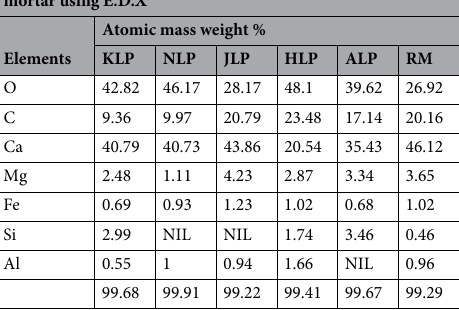
Table 13. Elemental analysis (E.D.X.) of modified organic lime paste. K.L.P.: kadukkai lime paste, N.L.P.: neelamari lime paste, J.L.P.: Jaggery lime paste, H.L.P.: hibiscus lime paste, A.L.P.: aloe vera lime